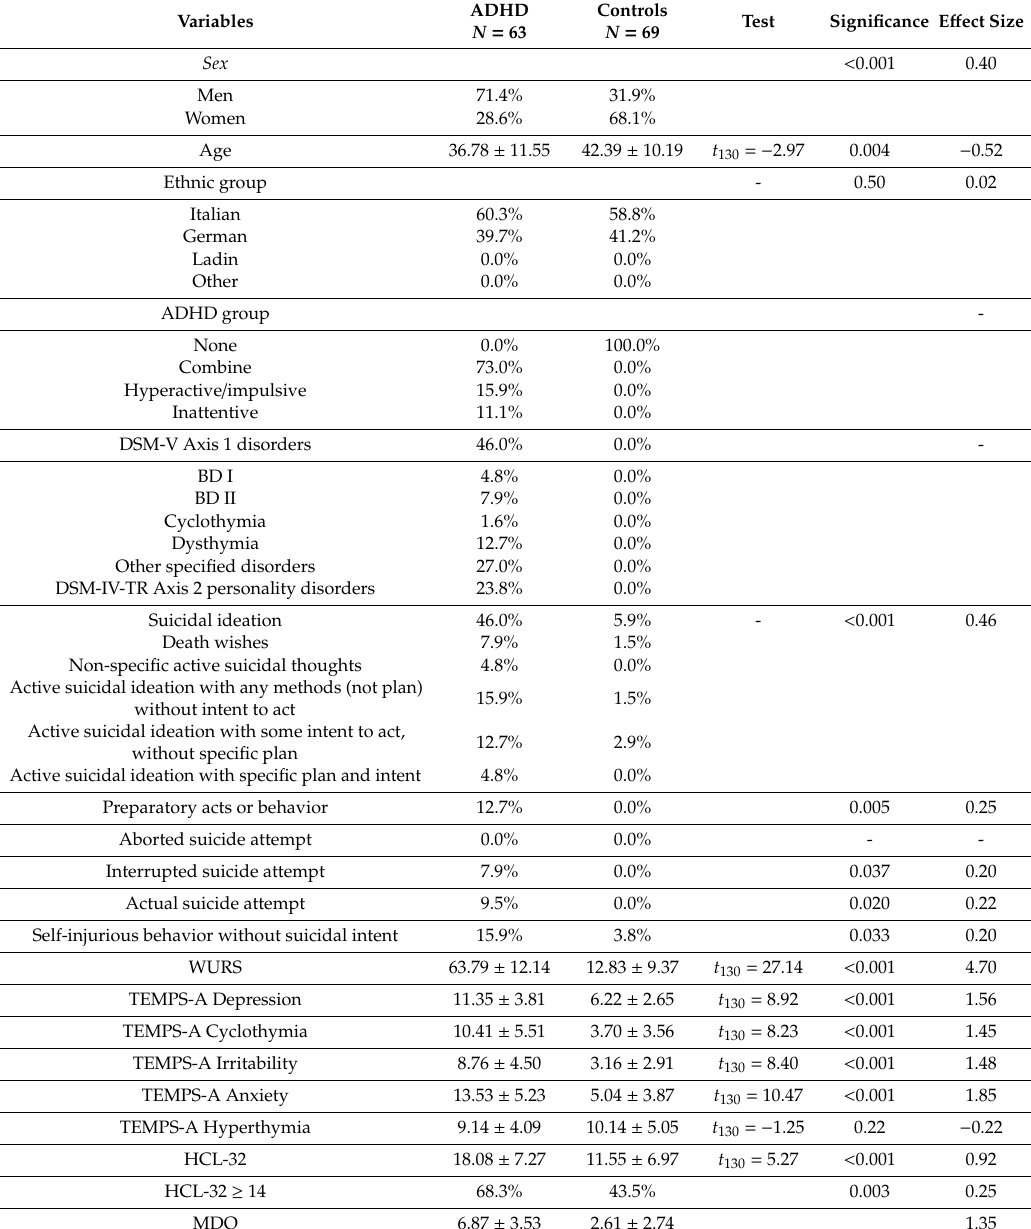
Table 1. Sociodemographic and clinical characteristics of the